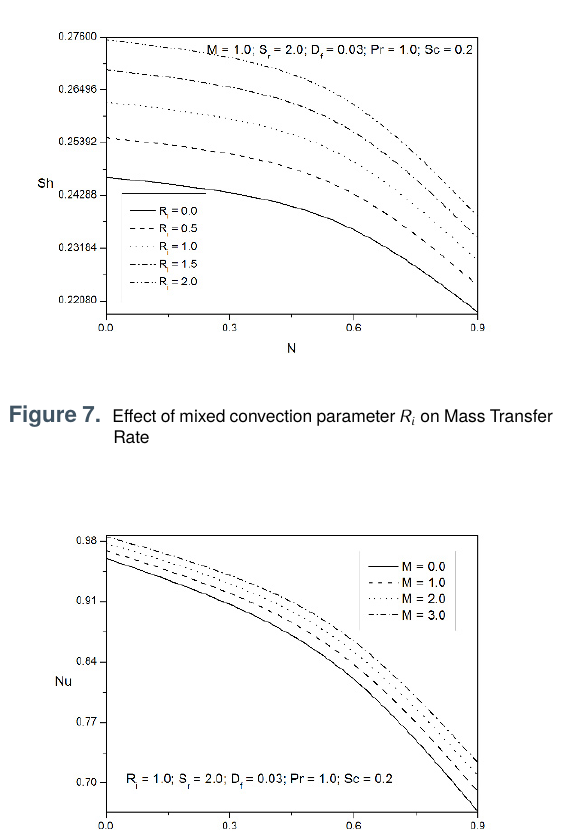
Figure 8. Effect of Magnetic parameter M on Heat Transfer Rate